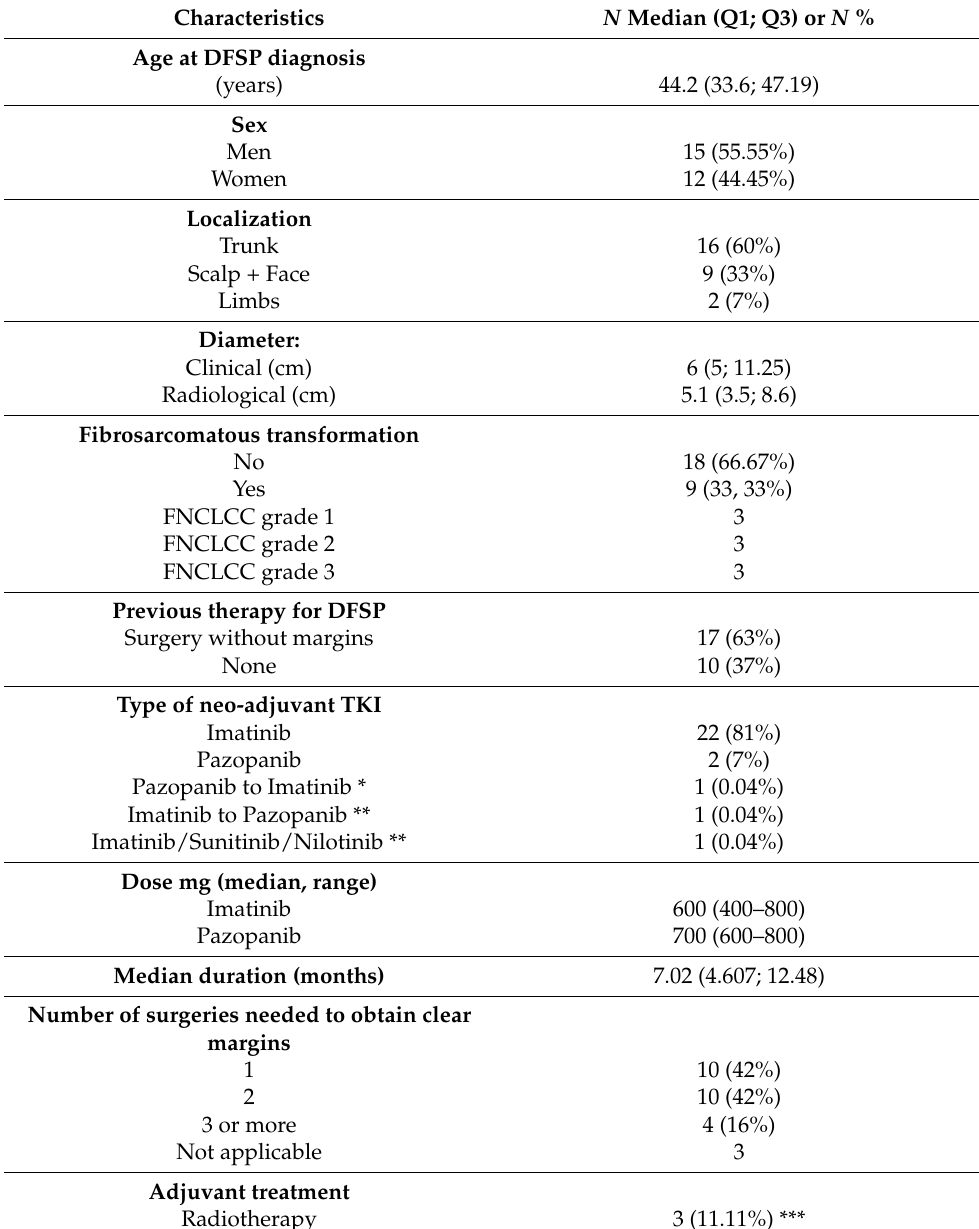
Table 1. Patients characteristics at baseline, and treatment characteristics N = 27